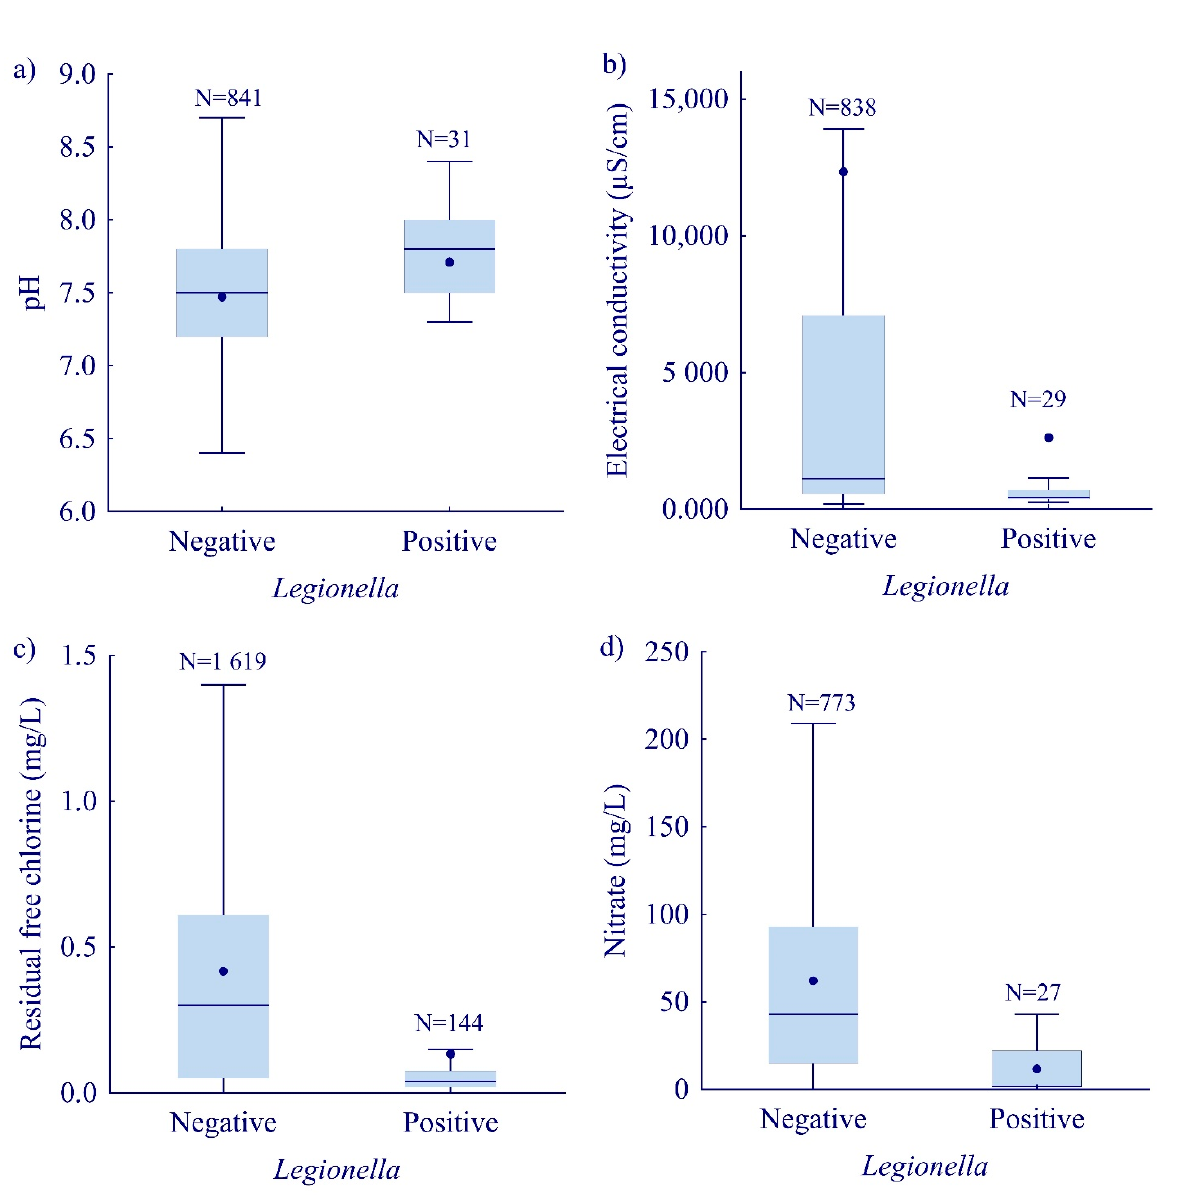
Figure 5. Legionella presence in relation to ( a ) pH value, ( b ) electrical conductivity, ( c ) concentration of residual free chlorine, ( d ) concentration of nitrate. Boxplots show median (line), mean (point), quartiles (boxes), non-outlier range (whiskers).